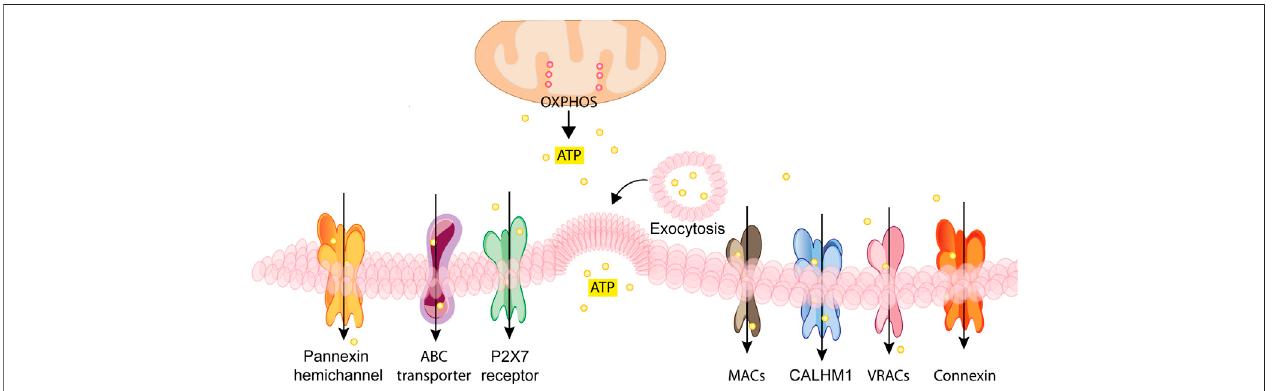
FIGURE 2 | Schematic rendition of the different pathways for regulated nucleotide release. ATP generated inside the cell by glycolysis and oxidative phosphorylation (OXPHOS) can be released through vesicular exocytosis, connexin or pannexin channels, speci fi c ATP binding cassette (ABC) transporters, calcium homeostasis modulators (CALHM) channels, the P2X7 receptor, maxi-anion channels (MACs) or through volume regulated ion channels (VRACs). These different pathways variably participate in ATP release in various cell types depending on the given patho-physiological context.